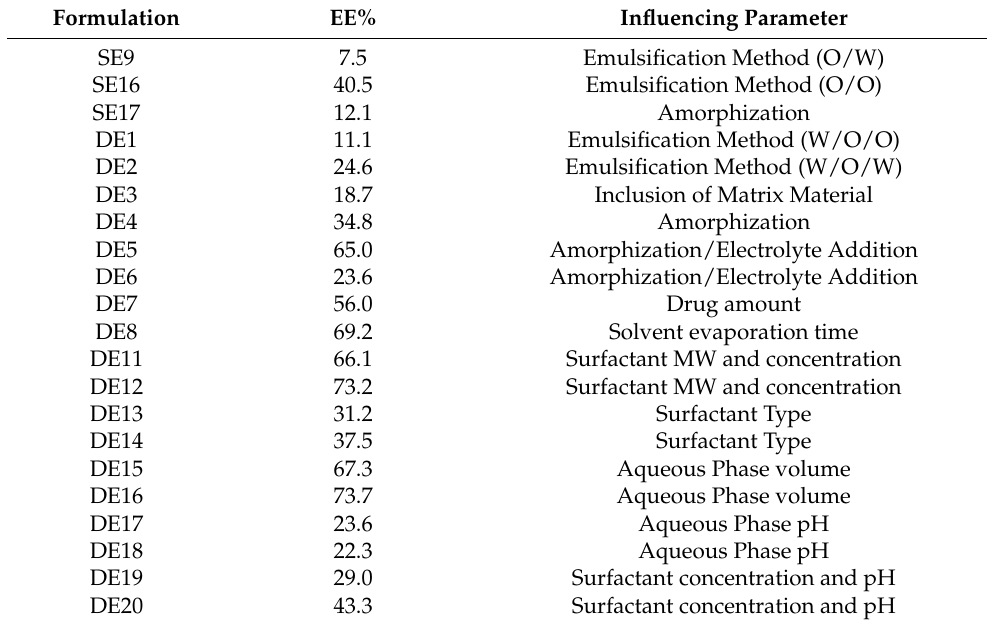
Table 3. Summary of EE% and the influencing parameters.